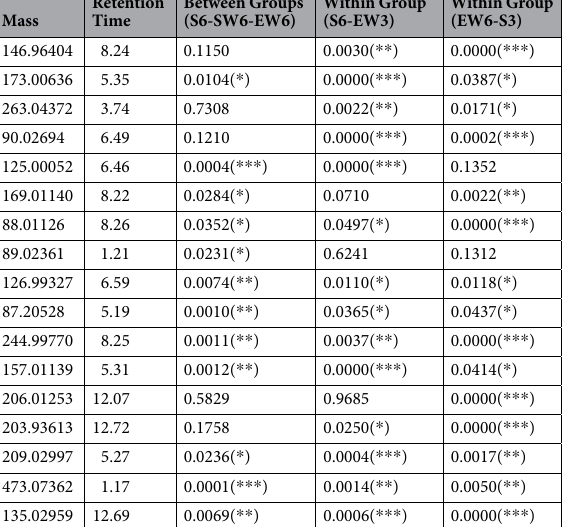
Table 4. Significance levels of 17 unknown features with consistent differences between behavioral states (p-values). The p-values generally reflect either a behavioral state by time interaction, with the levels generally decreasing in the sleep conditions and the levels remaining constant or increasing during the wakefulness conditions, or a main effect of behavioral state with lower values during sleep than the wake conditions. One exception is the features with mass of approximately 473, which displayed a spike at the onset of sleep that then decayed over time back to baseline levels. ( * )p < 0.05, ( ** )p < 0.01, ( *** )p <